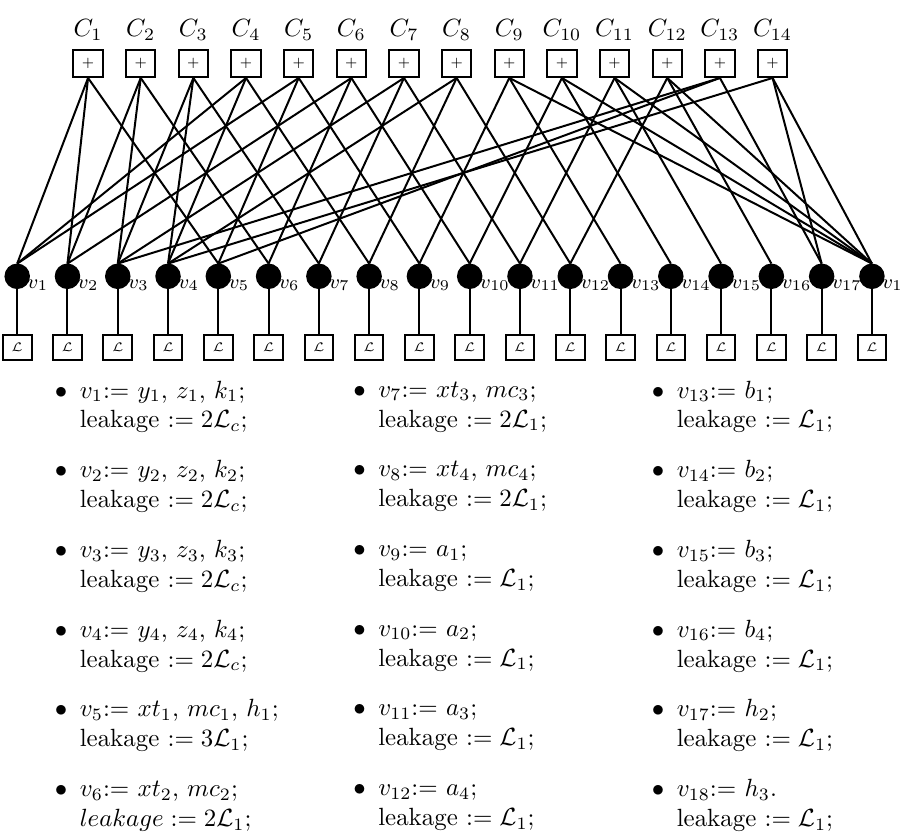
Figure 7: Tanner graph associated with one column of the first AES